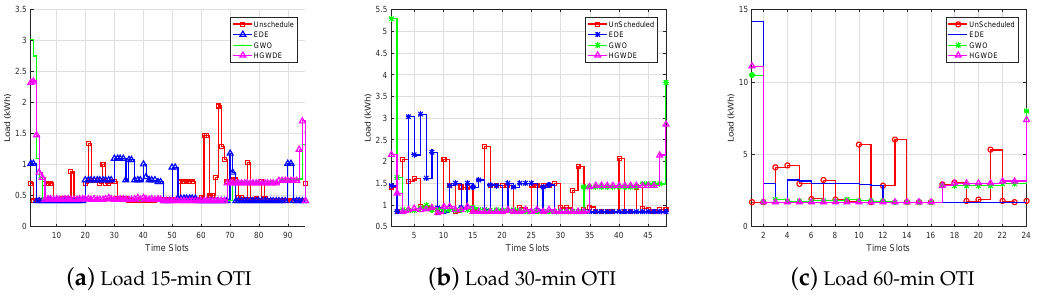
Figure 7. Load per time slot for